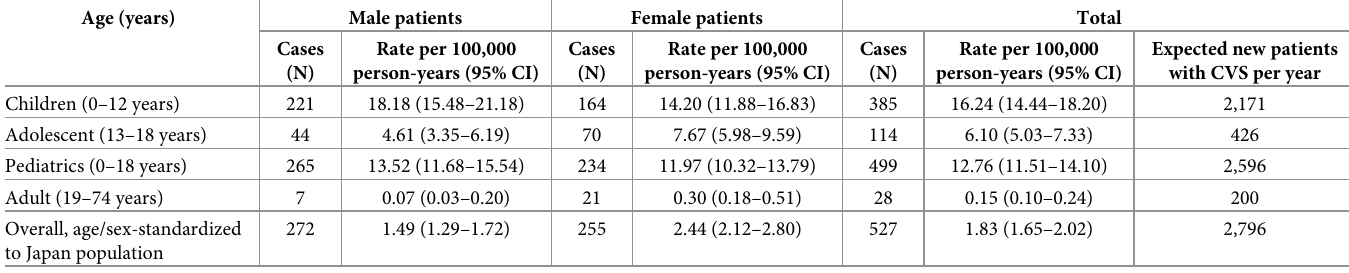
Table 3. Adjusted incidence rate of patients with CVS by age and